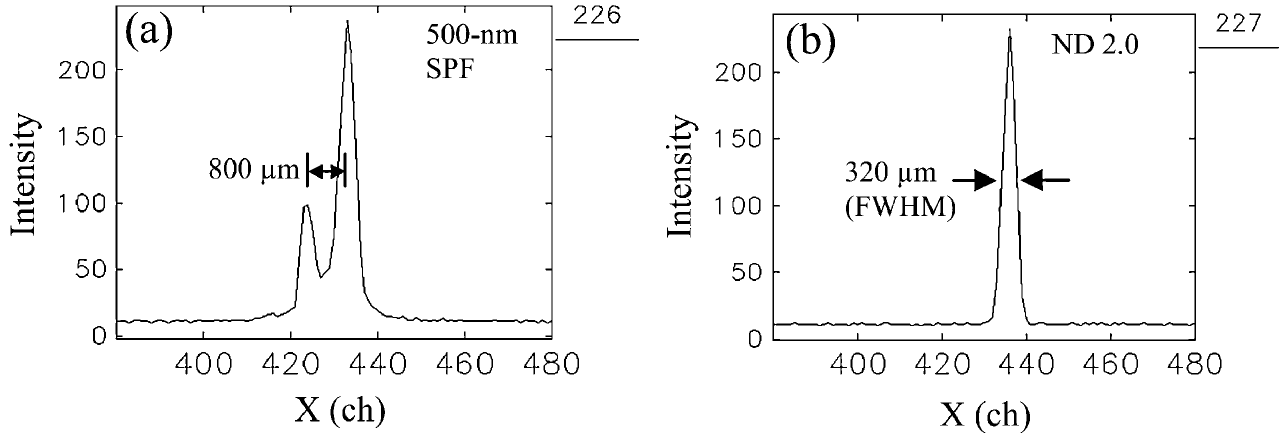
FIG. 11. Horizontal profiles from the 300-A VLD2 images (a) with the 500 nm shortpass filter (SPF) and (b) with an ND2.0 filter. The right-hand peak in (b) is enhanced by about 100 by SIM